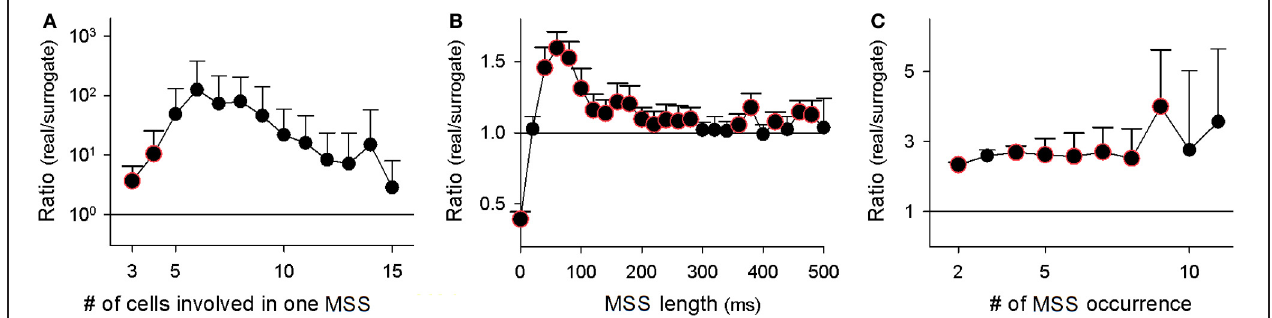
as ratios of values in real datasets to the mean value of 20 randomized surrogates. Color-edged circles are 5% significant data points between real datasets and surrogates (paired t -test). The data are the mean ± SDs of 9